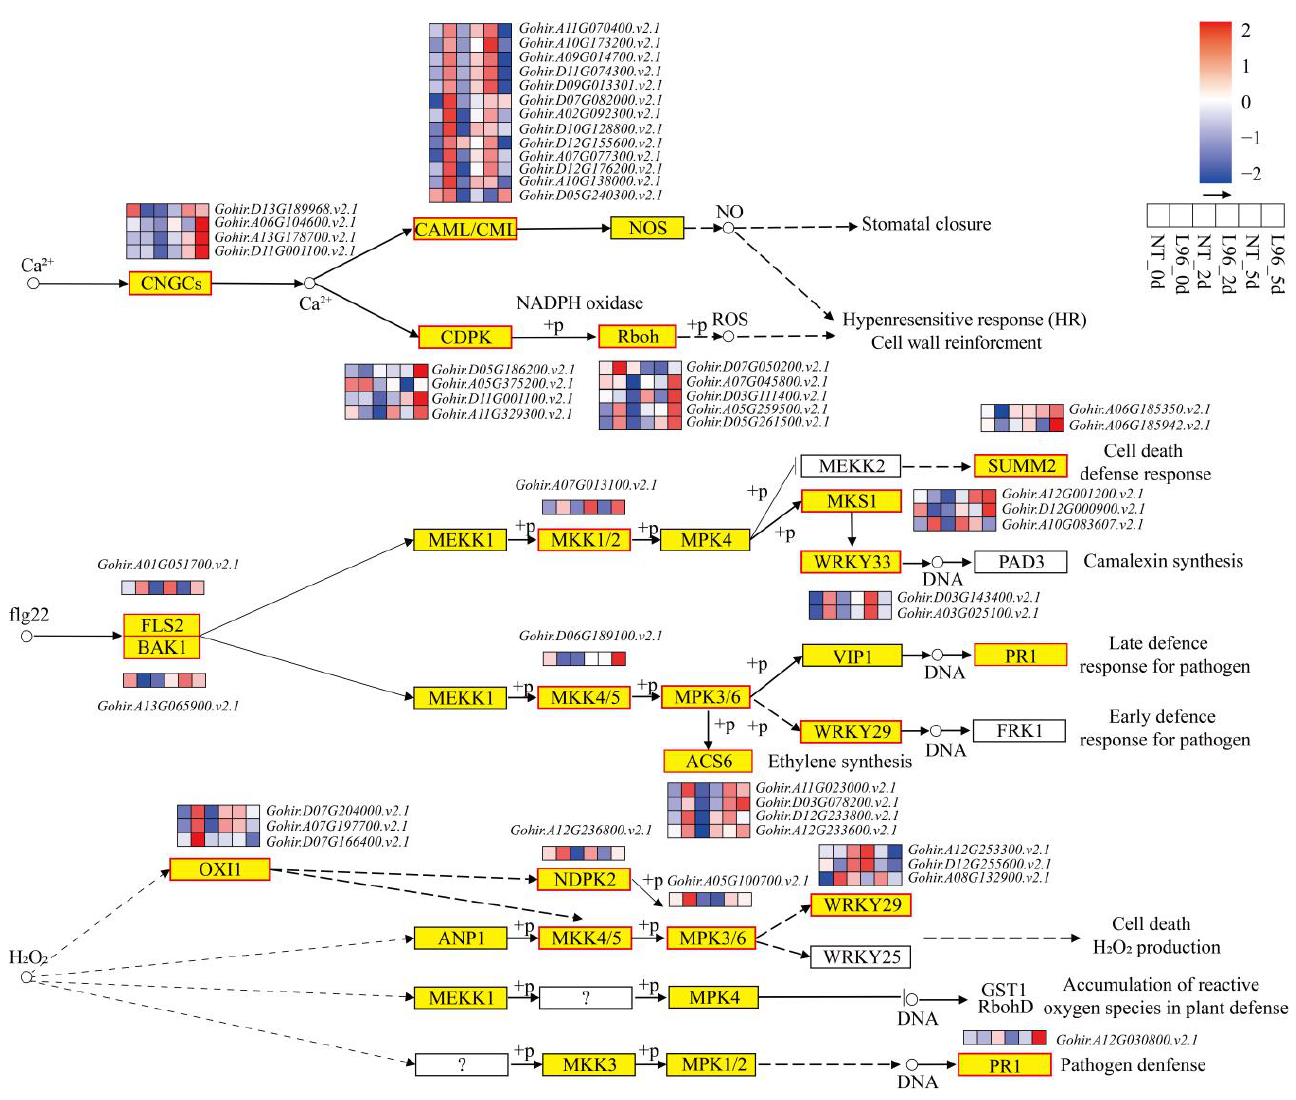
Figure 5. Plant pathogen interaction and MAPK signaling pathway activated by L96 and NT under salt stress. Heatmap shows FPKM values in each treatment, normalized using z-score.